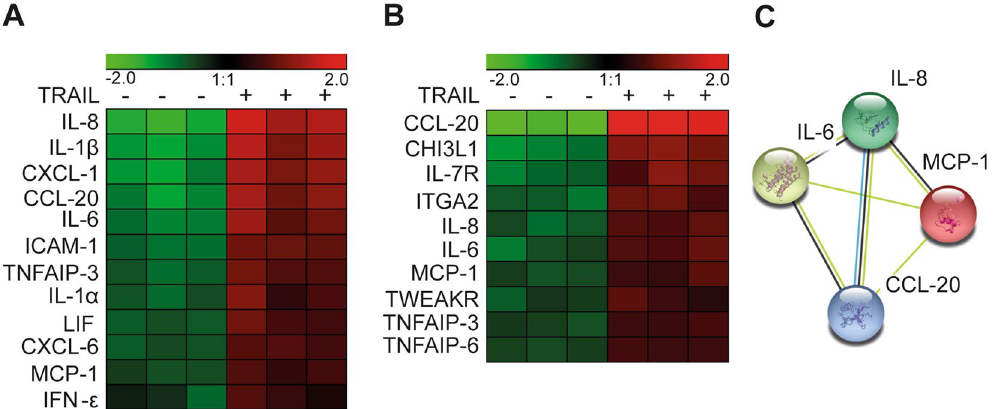
Figure 1. TRAIL induces a pro-inflammatory expression profile in human preadipocytes and adipocytes. SGBS preadipocytes and adipocytes on day 14 of adipogenic differentiation were treated with TRAIL ( + )(30 ng/ml) or vehicle ( − ) as indicated. After 12 hours, RNA was harvested and subjected to mRNA array analysis (GeneChip Human Gene 1.0 ST Array; Affymetrix). Heatmaps display the TRAIL-regulated inflammatory genes in preadipocytes ( A ) and adipocytes ( B ). An evidence-based STRING 10 analysis was performed to visualize the network of TRAIL-regulated genes in preadipocytes and in adipocytes ( C